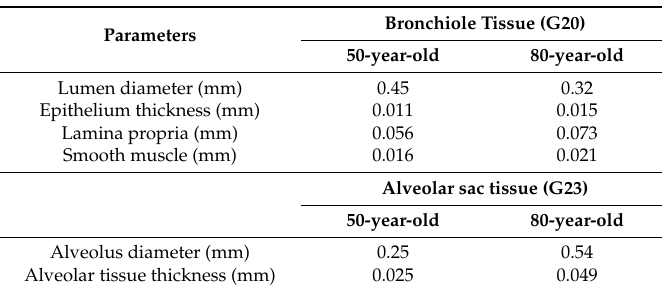
Table 1. Tissue morphological parameters at G20 and G23 for normal (50-year-old) and aged (80-year-old) models considered in this